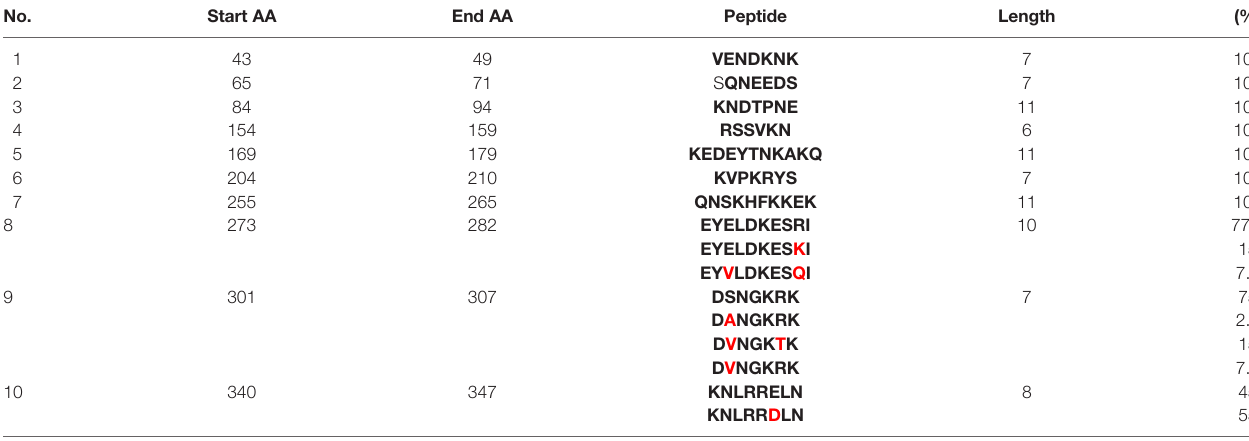
Amino acids in red indicate polymorphism within